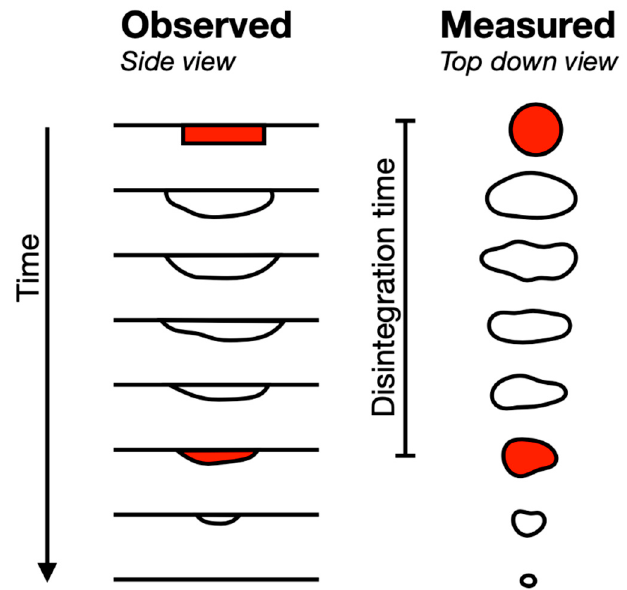
Figure 3. Observed (left) vs. measured (right) Orodispersible tablets (ODT) disintegration. Note: the measured ‘disintegration time’, which is the time taken to reach an area equal to starting area, was used to calculate mean disintegration time of the ODTs.